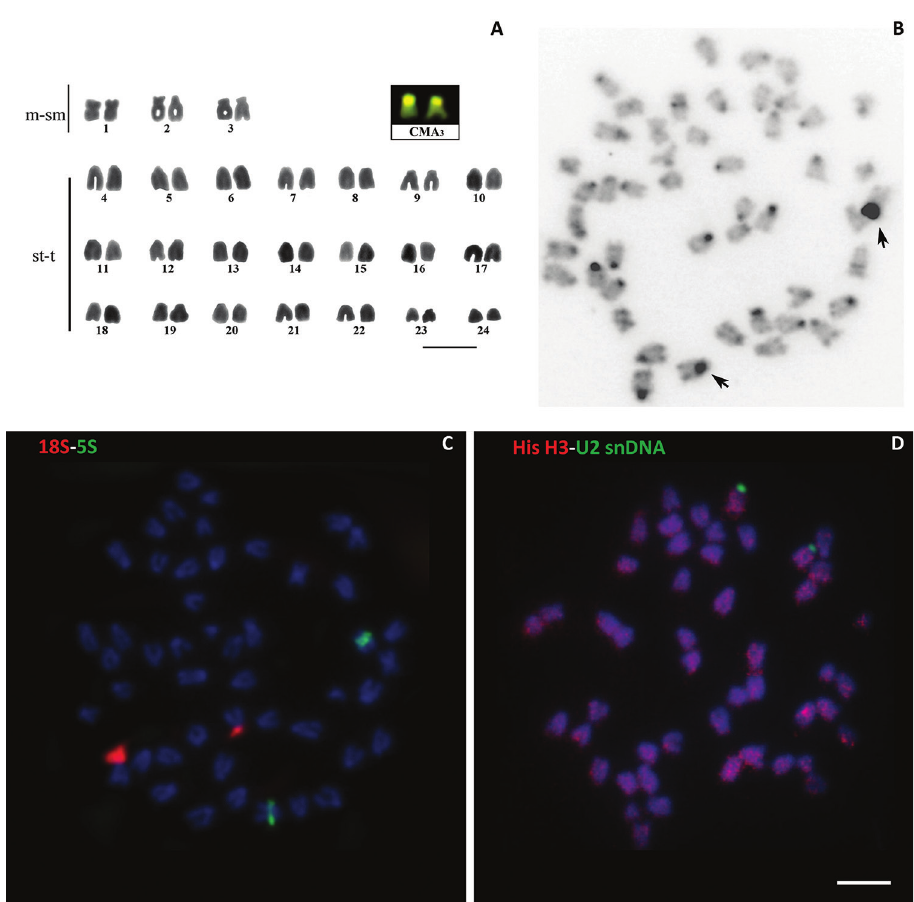
Figure 1. Karyotype of O. ascotanensis (female), 2n=48. A Giemsa-stained karyotype and CMA bands (box) B C-banded somatic metaphase C metaphases counterstained with DAPI after FISH treat- ment using 5S and 18S rDNA probes D metaphases counterstained with U2 snDNA/histone H3 DNA probes. The arrows show a block of HC on the short arm of pair 3. Bar =